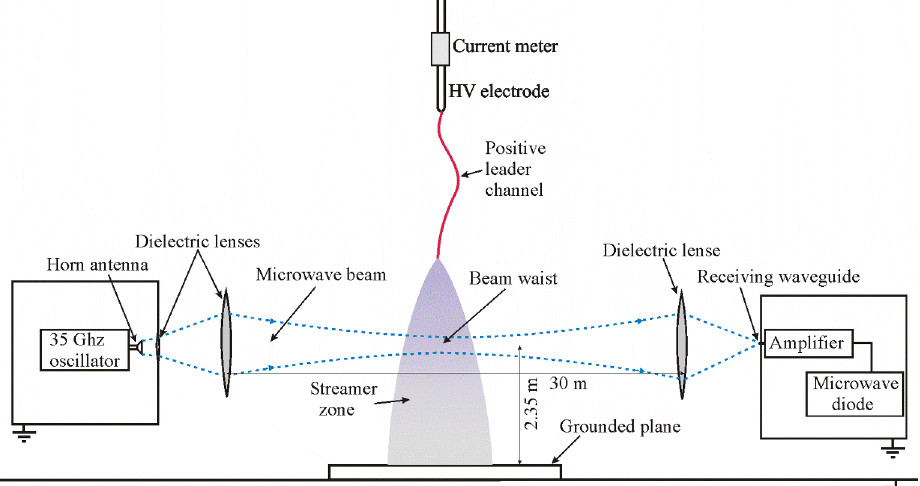
Fig. 1. Schematic representation of experimental